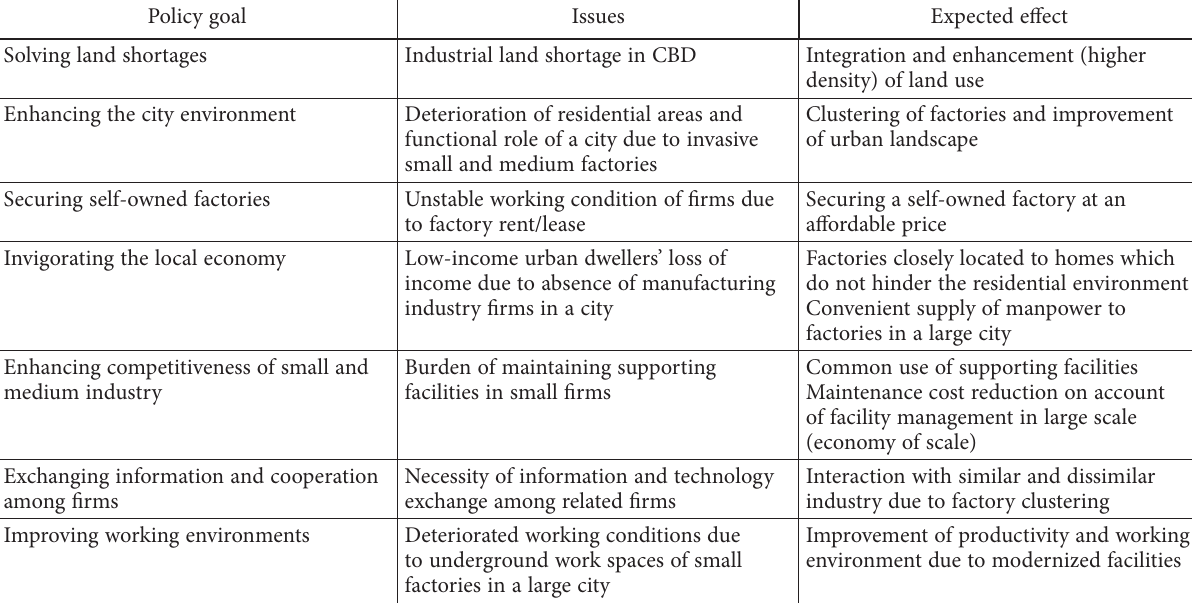
Table 2. Flatted factory policy goal and expected effects (source: Lee, 2011)